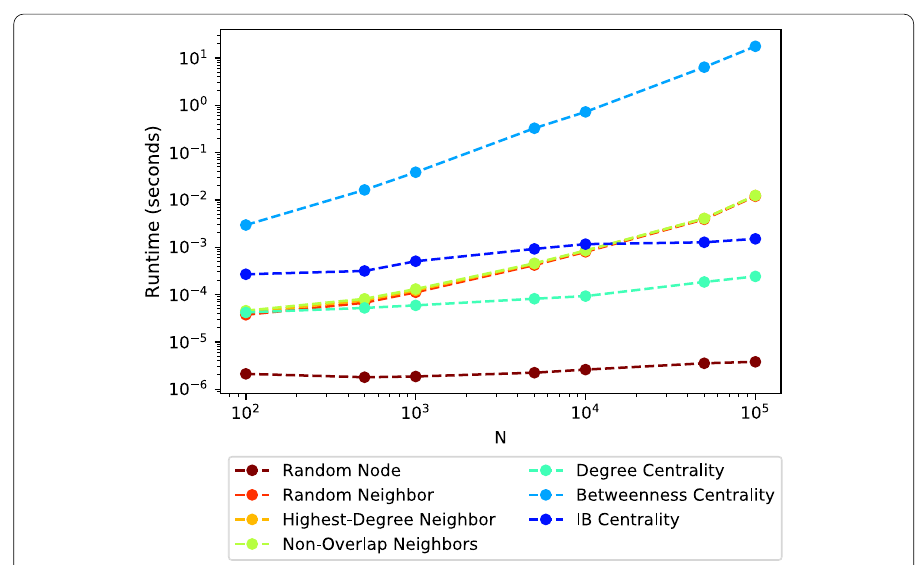
Fig. 9 Median runtime taken to vaccinate a single node as a function of the network size N . Both axes are presented in log scale. IB Centrality manages to maintain a relatively fixed runtime, which is considerably better than that of Betweenness Centrality in all examined cases, and slightly better than those of the three acquaintance vaccination strategies for large network